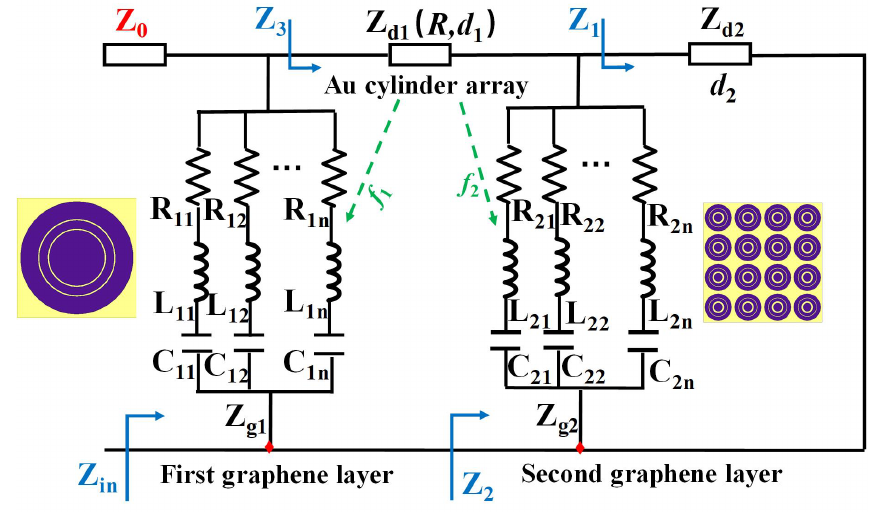
Figure 3. The diagrammatic sketch of an equivalent circuit model of the proposed